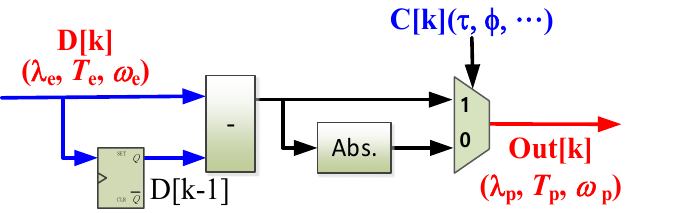
Figure 3. Block diagram of the predictive control model with input flux error ( λ e ), torque error ( T e ), and speed error ( ω e ).